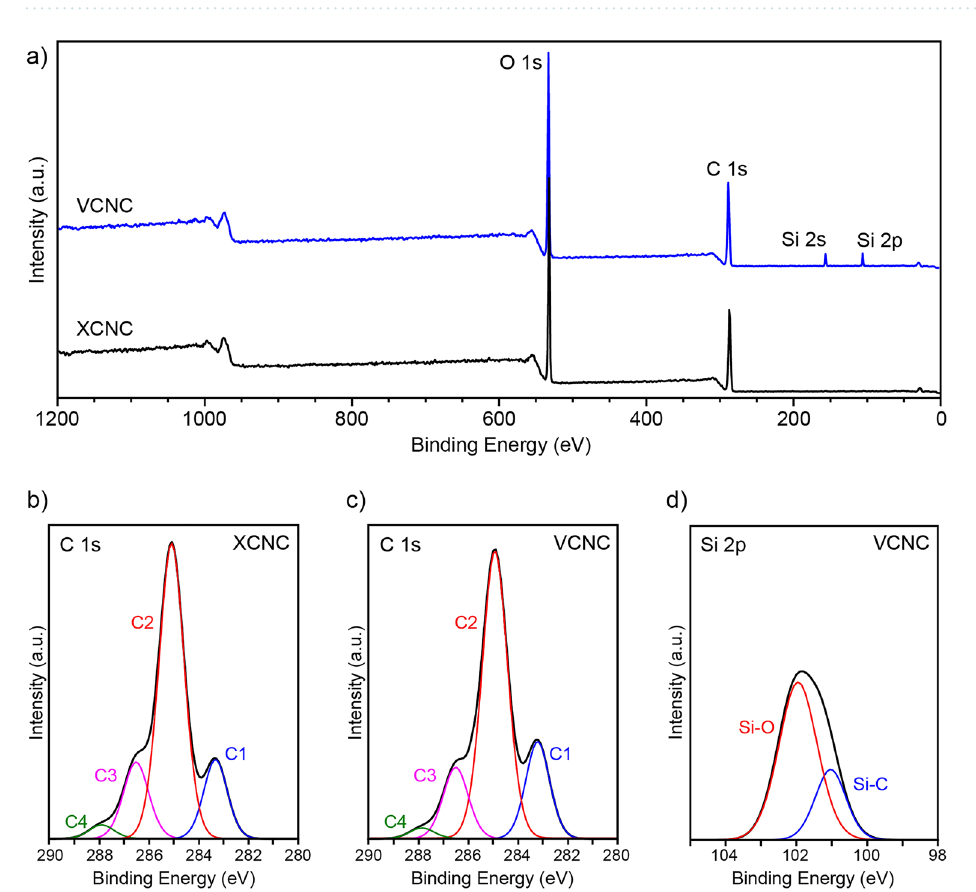
Figure 8. XPS spectra; ( a ) survey spectra of XCNC and VCNC, ( b ) high-resolution spectra of C 1 s of XCNC, ( c ) high-resolution spectra of C 1 s of VCNC, and ( d ) high-resolution spectra of Si 2 p of